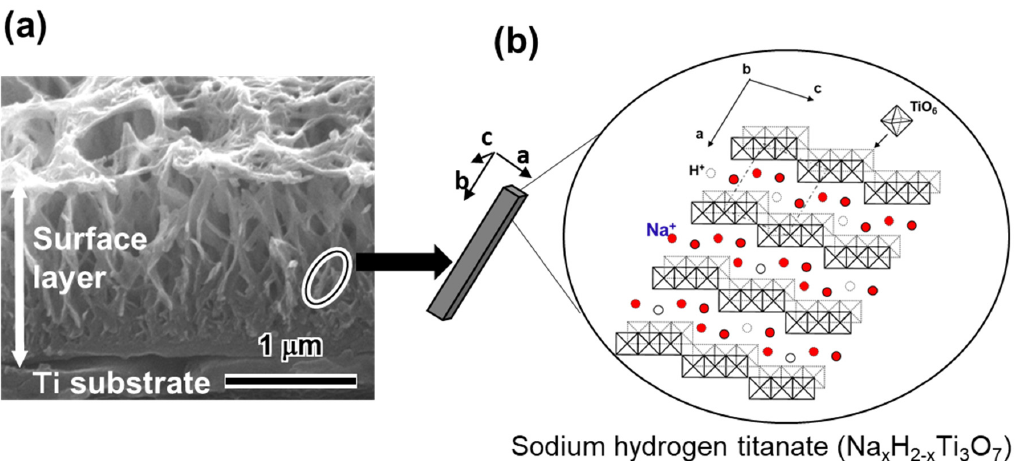
Figure 4. ( a ) Cross section SEM image of Ti subjected to NaOH treatment and ( b ) illustration of sodium hydrogen titanate structure. (Reproduced from ( a ) [15], ( b ) [85]).